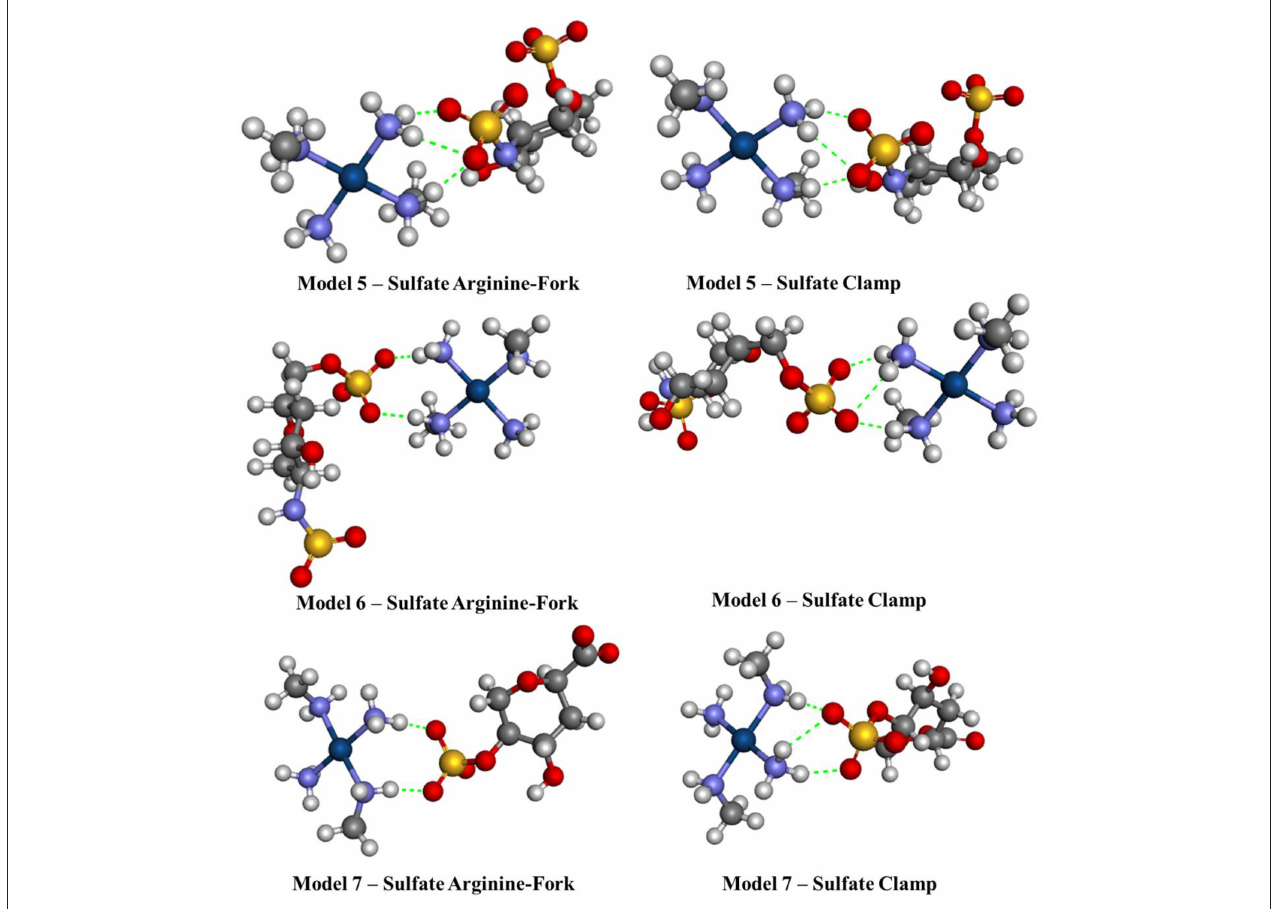
FIGURE 8 | Optimized structures of each different sulfate models 5–7 using the BHandH functional.